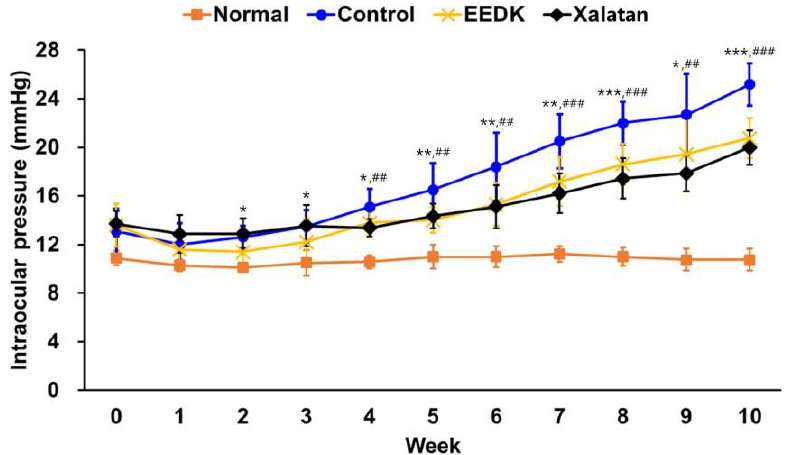
Figure 4. Comparison of intraocular pressure (IOP) of the DBA/2 mouse. IOPs for all groups were measured by a rebound tonometer. Values represent the mean ± S.E.M. for 10 animals. The values of * p < 0.05, ** p < 0.01 and *** p < 0.001 indicate significant difference when the EEDK-administered group was compared with control group. ## p < 0.01 and ### p < 0.001 indicate significant difference between the Xalatan-administered group and control group. IOPs in EEDK- or Xalatan-administered group were measured by a rebound tonometer.